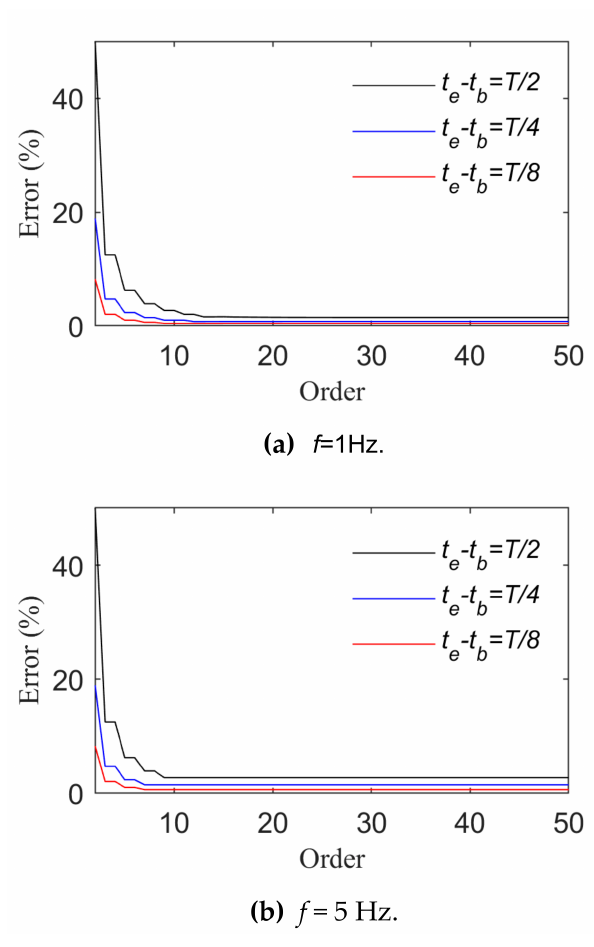
Figure 7. Fitting effects of triangular wave loads (Case 1).